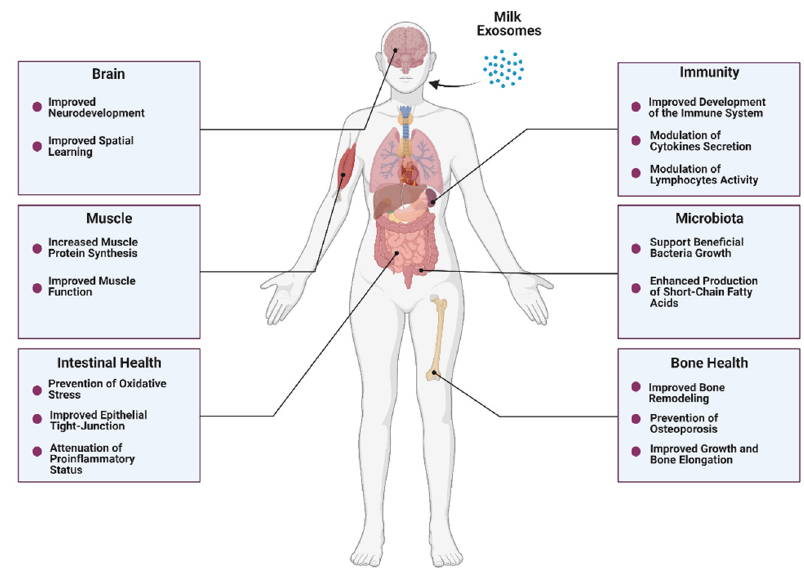
Figure 3. Potential beneficial effects of milk exosomes on overall health.